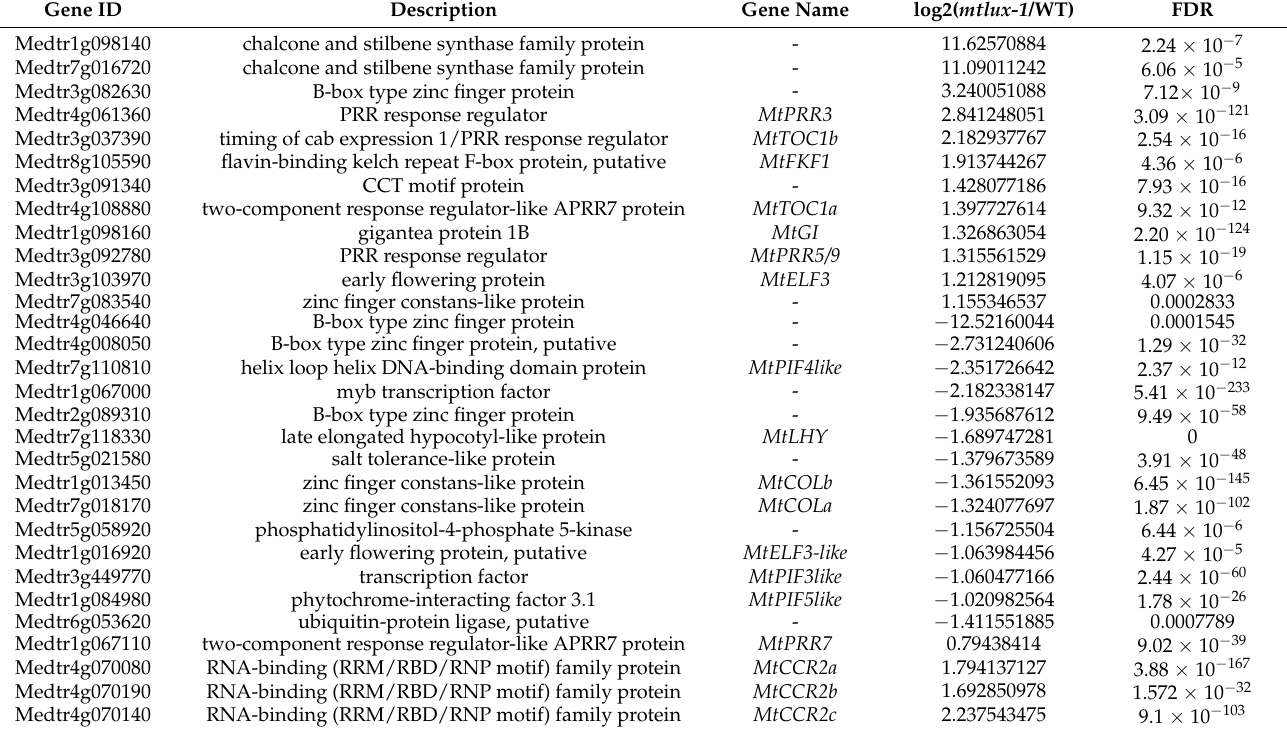
Table 1. Differentially expressed genes (DEGs) of circadian rhythm pathway in the leaves of the mtlux-1 mutant compared to the